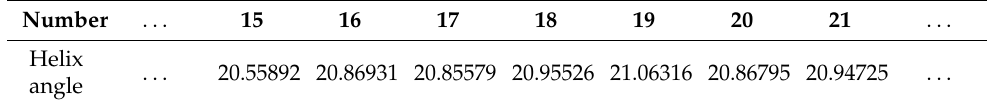
Table 3. Analysis of helix angle with an offset value of